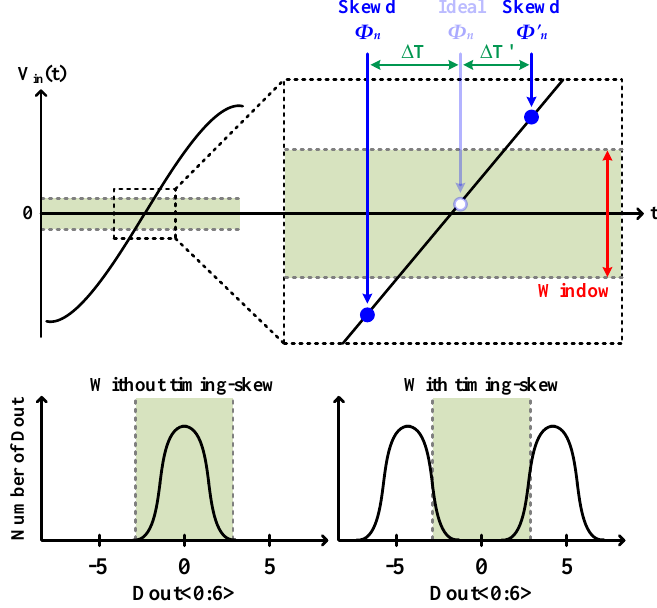
Figure 13. Histograms of D out without and with timing skew.